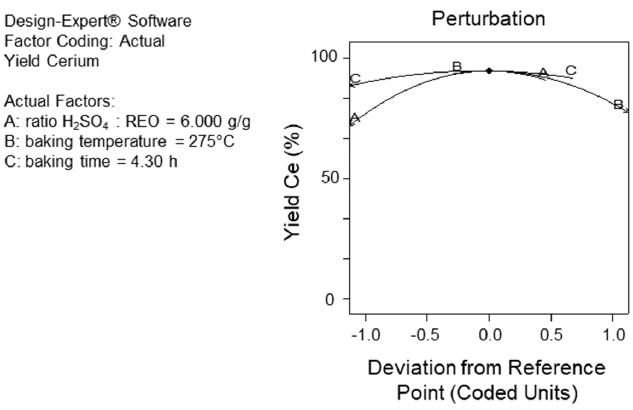
Figure 8. Normal plot of residuals for the response “Yield Ce.”